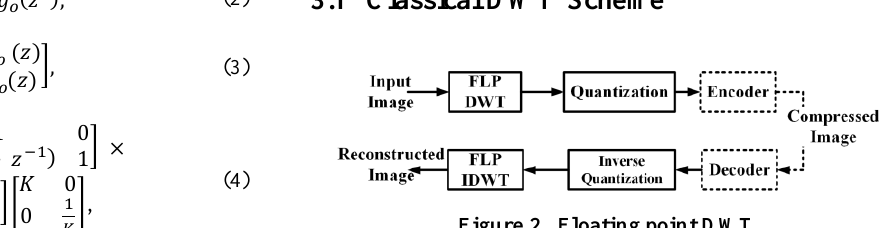
Figure 2. Floating point DWT.